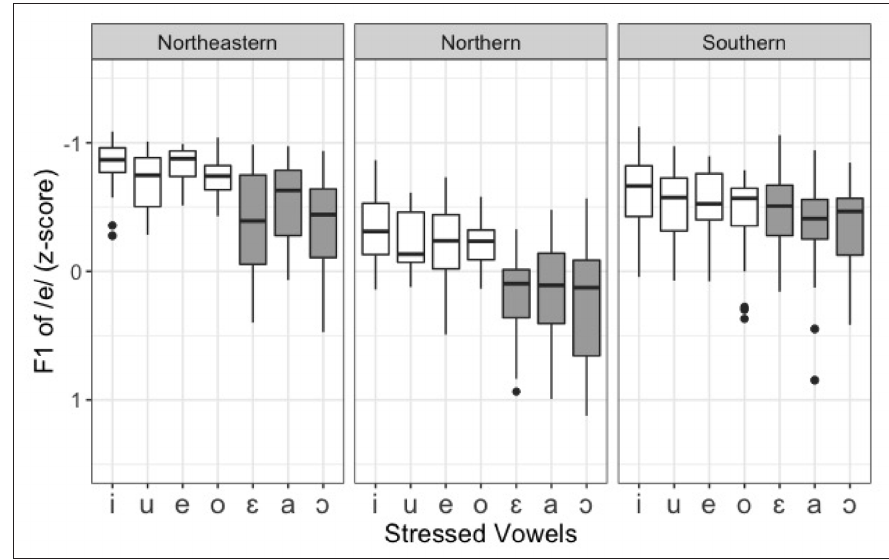
Figure 4: F1 (z-score) of /e/ as a function of the seven stressed vowels by dialect; white boxes = non-low vowels, grey boxes = low vowels.